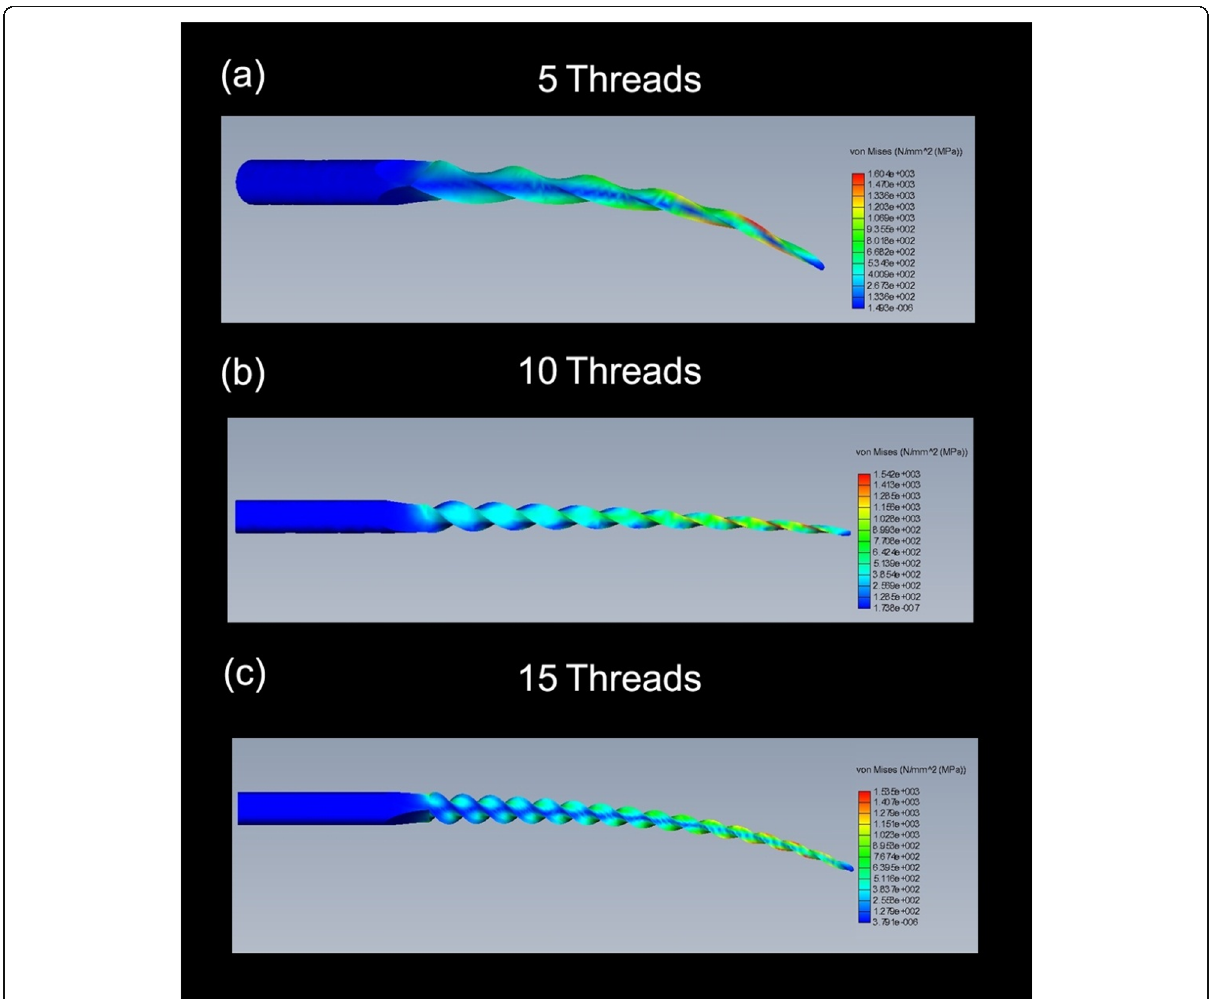
Fig. 5 Stress distribution during bending of different tested file pitch. a 5 threads. b 10 threads. c 15